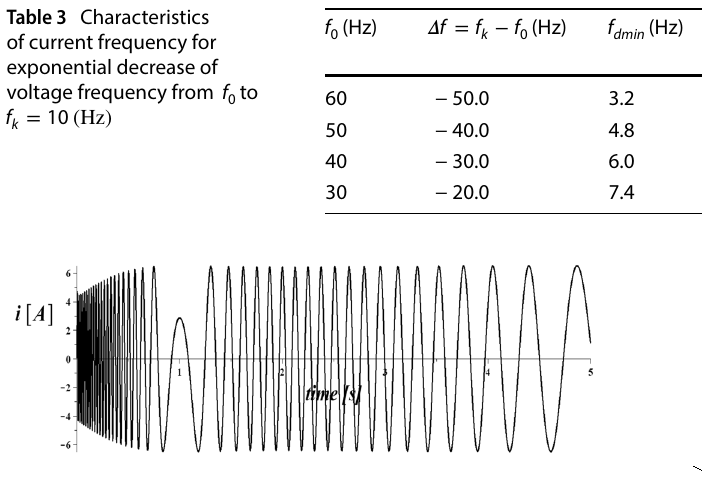
Fig. 16 Electric current in R,L circuit for exponential voltage fre- quency decrease ( T = 0.075 (s) ) from f 0 = 40 (Hz) to f k = 0 (Hz)